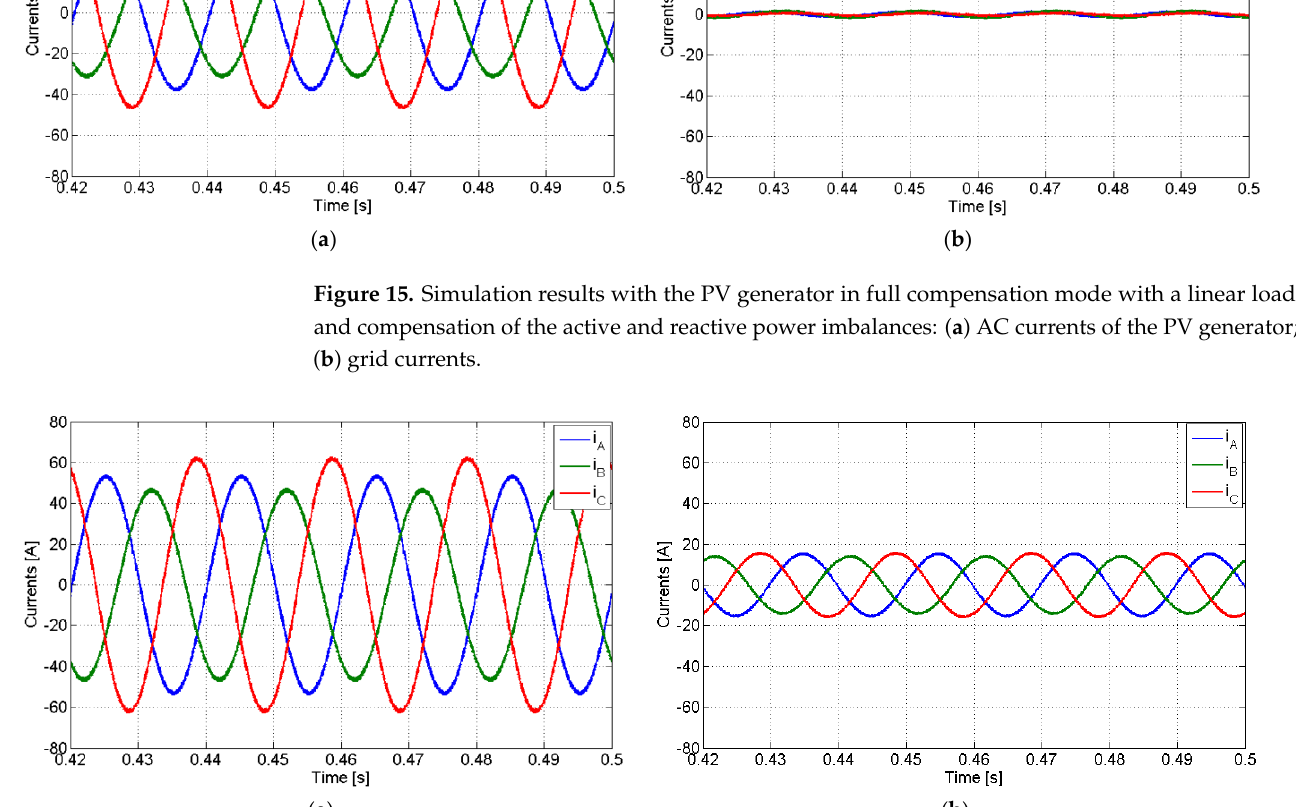
Figure 16. Simulation results with the PV generator in overcompensation mode with a linear load and compensation of the active and reactive power imbalances: ( a ) AC currents of the PV generator; ( b ) grid currents.